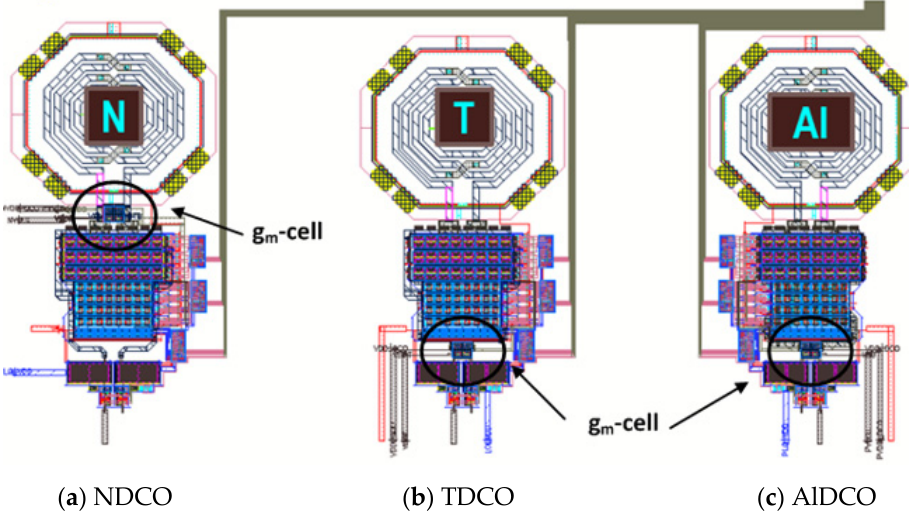
Figure 6. The layout of the designed DCOs.